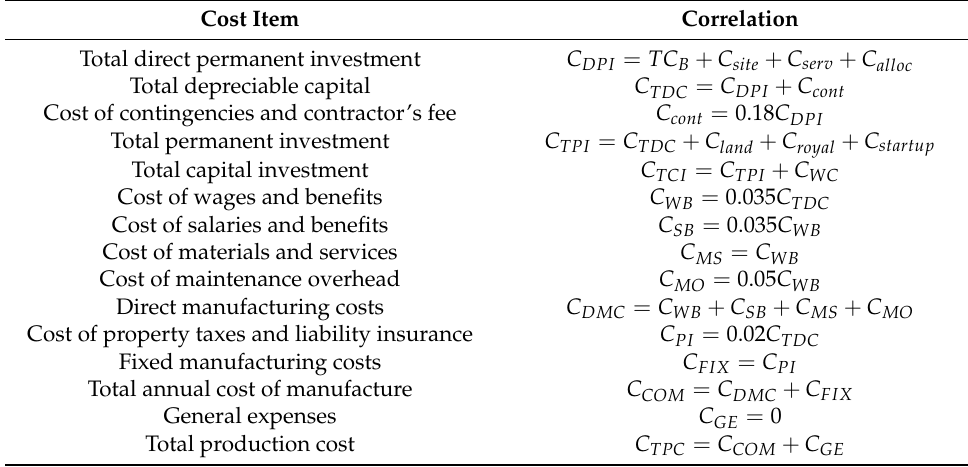
Table 7. The total capital investment and production cost